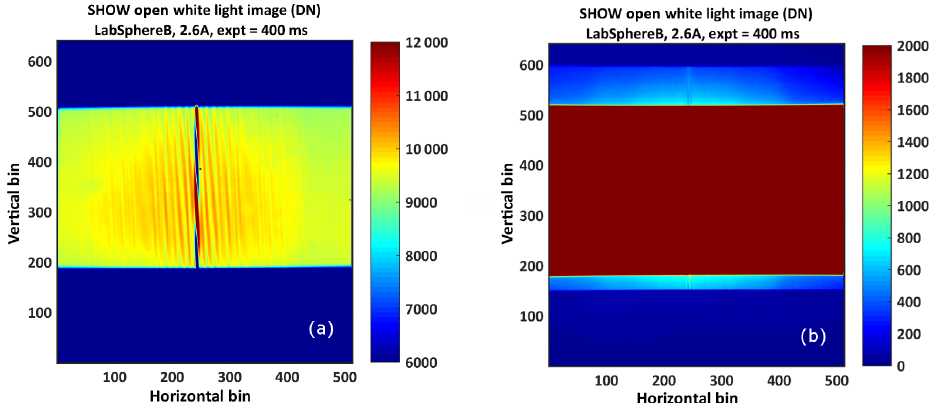
Figure 3. An example dark corrected white light image (a) and the same image with a colour scale that shows the SHOW field of view in red and the edge of the grating in light blue (b) .